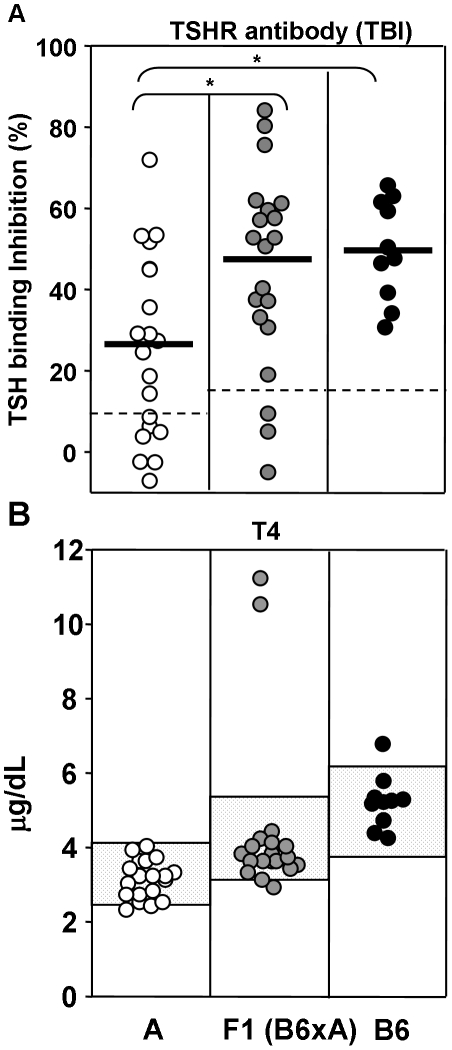
TSHR antibodies measured by TSH binding inhibition (TBI) and serum T4 in A/J, B6AF1 and B6 mice immunized three times with TSHR A-subunit-adenovirus; B6 data from Chen et al [15].Values are shown for individual mice (white, A/J; grey, B6XA F1; black, B6). A) TBI (% inhibition of labeled TSH binding to its receptor). Broad black bars indicate the mean TBI values; horizontal broken lines: mean + 2SD for control-adenovirus immunized mice. *, values significantly greater than for B6 mice (ANOVA; Holme -Sidak method, p<0.05). B) T4 (µg/dL). Speckled box: mean + 2SD for Con-Ad immunized mice of each strain.